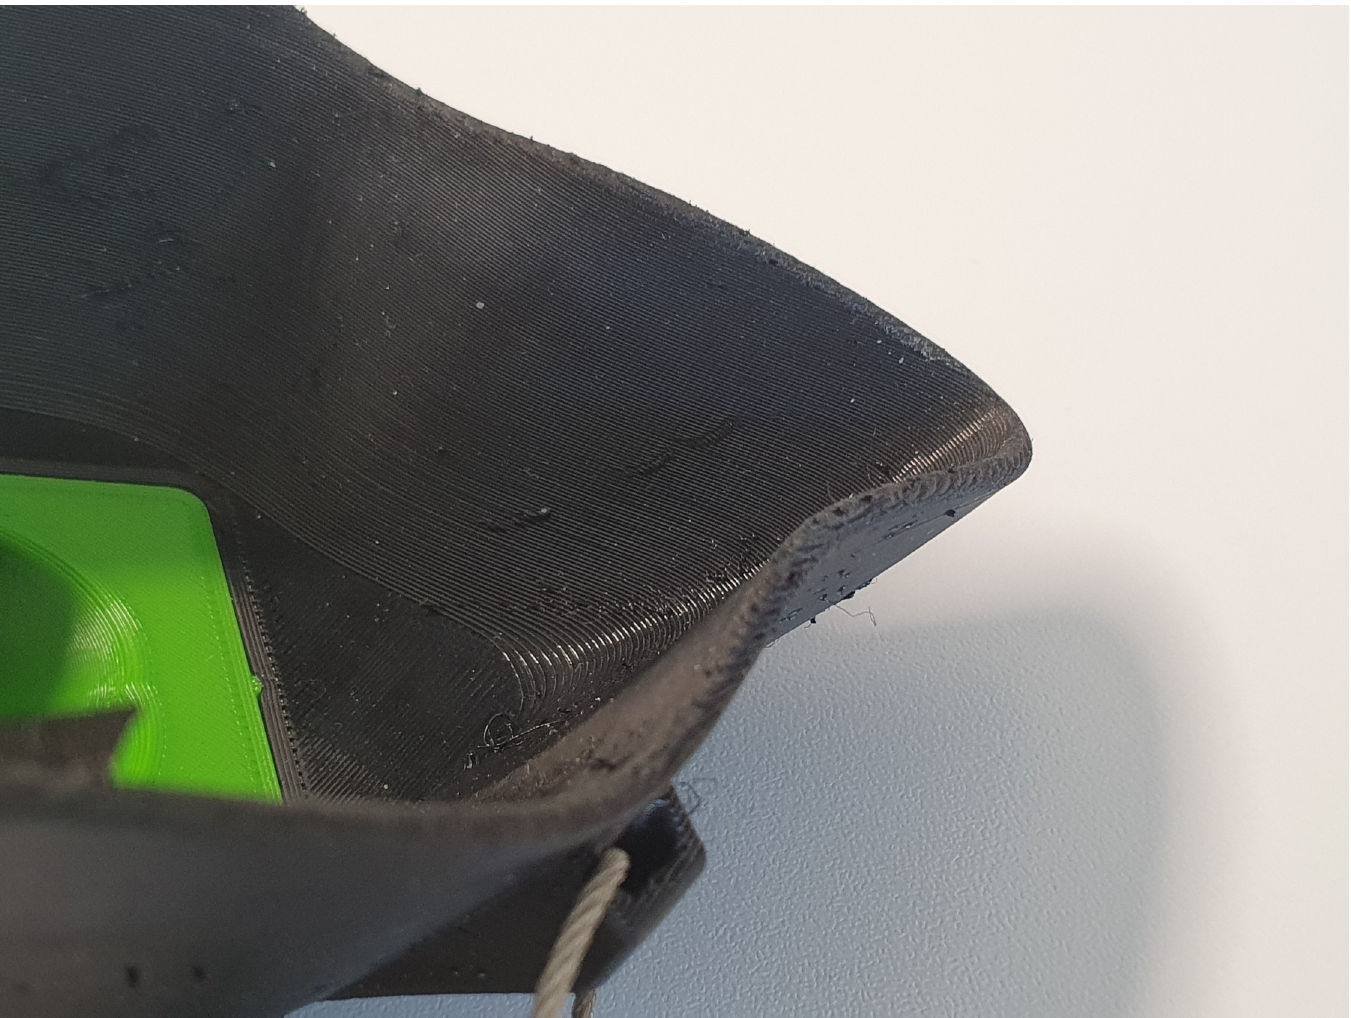
Fig 6. Edge of the printed mask. The edge of the printed mask is made of the same material as the mask itself and therefore relatively thin.